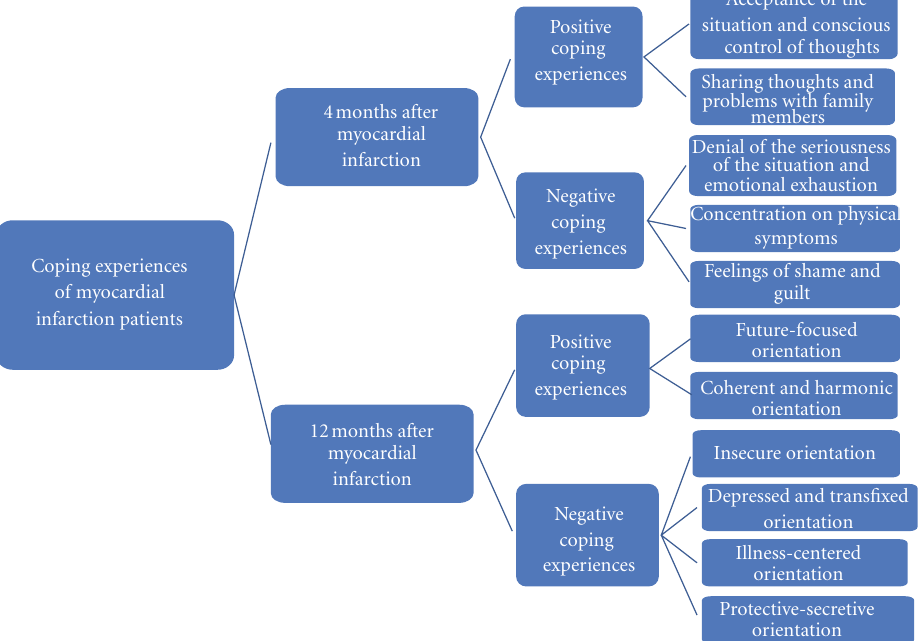
Figure 1: Di ff erent coping pathways towards di ff erent coping